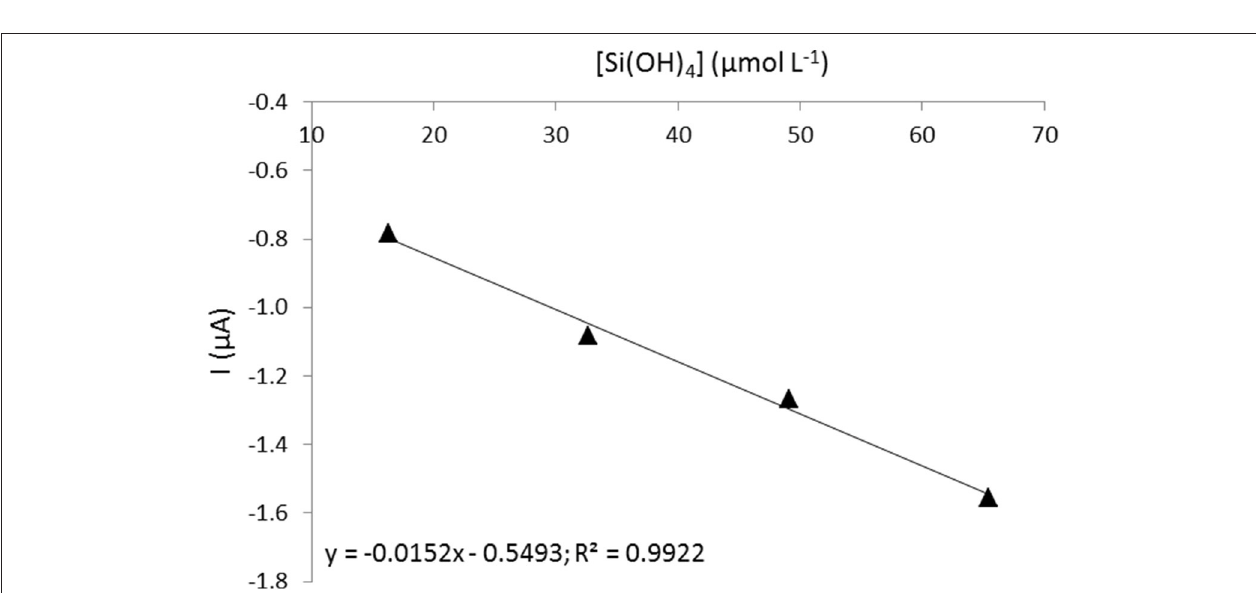
FIGURE 5 | Calibration prior to deployment off Coquimbo (Chile) for 20min complexation time.